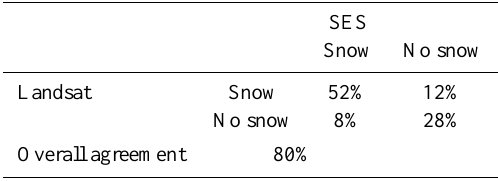
Table 3. Confusion matrix comparing Landsat snow cover and modelled snow cover for the Obergurgl catchment on 30 June 2001. SES Snow No snow Landsat Snow 52% 12% No snow 8% 28% Overall agreement